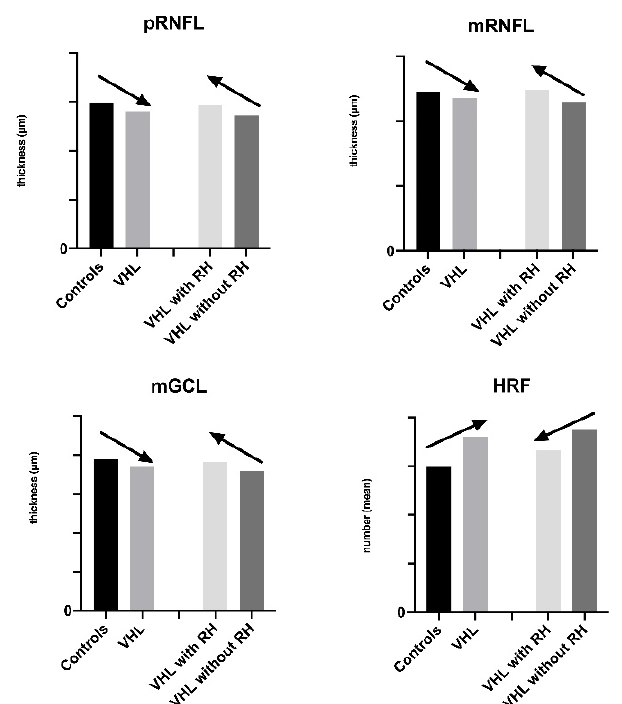
Figure 2. Trend of retinal thickness and of hyperreflective retinal foci expression in the analyzed groups. VHL: Von Hippel–Lindau; RH: Retinal Hemangioblastoma; pRNFL: peripapillary Retinal Nerve Fiber Layer; mRNFL: macular Retinal Nerve Fiber Layer; GCL: Ganglion Cell Layer; HRF: Hyperreflective Retinal